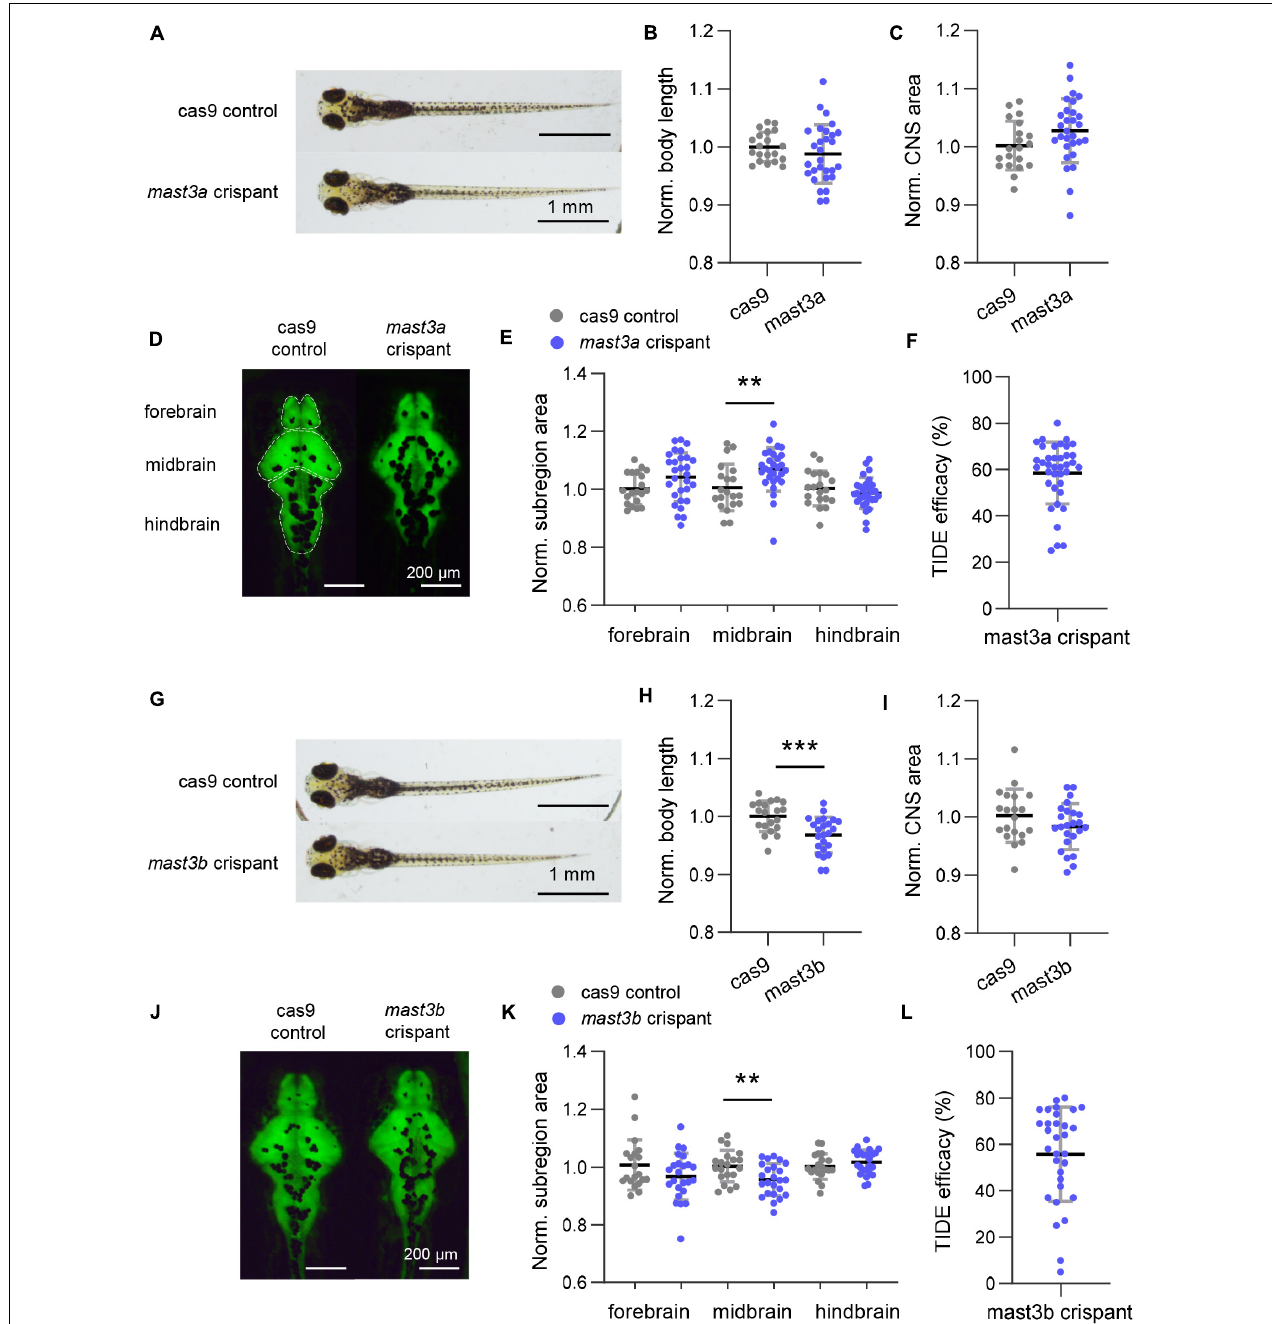
FIGURE 5 | Disruption of zebrafish mast3a and mast3b led to abnormal central nervous system (CNS) morphology. (A) Representative bright-field imaging of larval zebrafish at six dpf (dorsal view). Top, cas9 injected control; bottom, mast3a F0 CRISPR (crispant). (B) Measurements of body length in cas9 injected control ( n = 20 fish) vs. mast3a crispant ( n = 29 fish). Data were normalized to the average body length of cas9 control group. (C) Normalized CNS area in cas9 injected controls vs. mast3a crispants. Data were corrected by the normalized body length of individual larvae. (D) Representative imaging of HuC: eGFP expressed larval zebrafish shows CNS fluorescence pattern at six dpf (dorsal view). Left, cas9 injected control; right, mast3a crispant. White dash line highlights the CNS subregions, forebrain, midbrain, and hindbrain, for measurement. (E) Normalized CNS subregion area in cas9 injected control vs. mast3a crispant. Data were normalized to the average of each subregion area of cas9 control group, and then corrected by the normalized body length of individual larvae (gray dot, cas9 control; blue dot, mast3a crispant). (F) CRISPR efficacy calculated via TIDE method of individual mast3a crispant used in phenotypic study ( n = 38 fish). (G–L) Data from mast3b crispant study (for imaging study, n = 20 fish for cas9 control, and n = 24 fish for mast3b crispant; n = 31 crispant for TIDE efficacy verification). Scale bars as indicated in the figure. Error bars indicate SD. Statistical significance is indicated as ** p < 0.01, and *** p < 0.001.